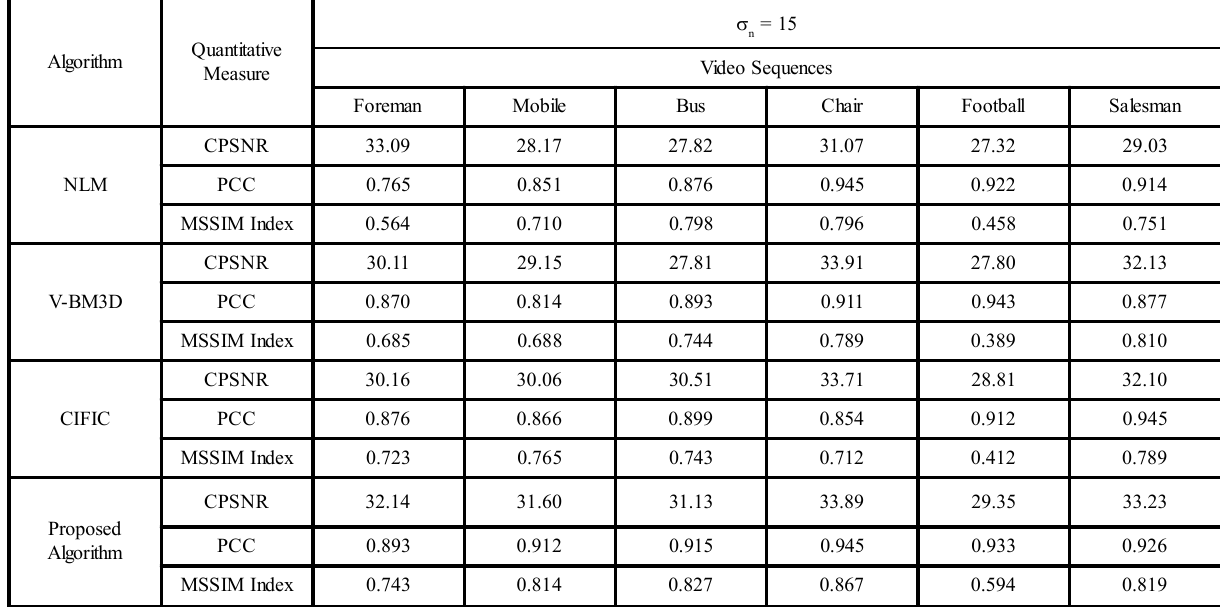
TABLE 2. QUANTITATIVE COMPARISON OF NLM, V-BM3D, CIFIC AND PROPOSED WITH UNIFORM GAUSSIAN NOISE. ALL CPSNR VALUES ARE IN DECIBEL